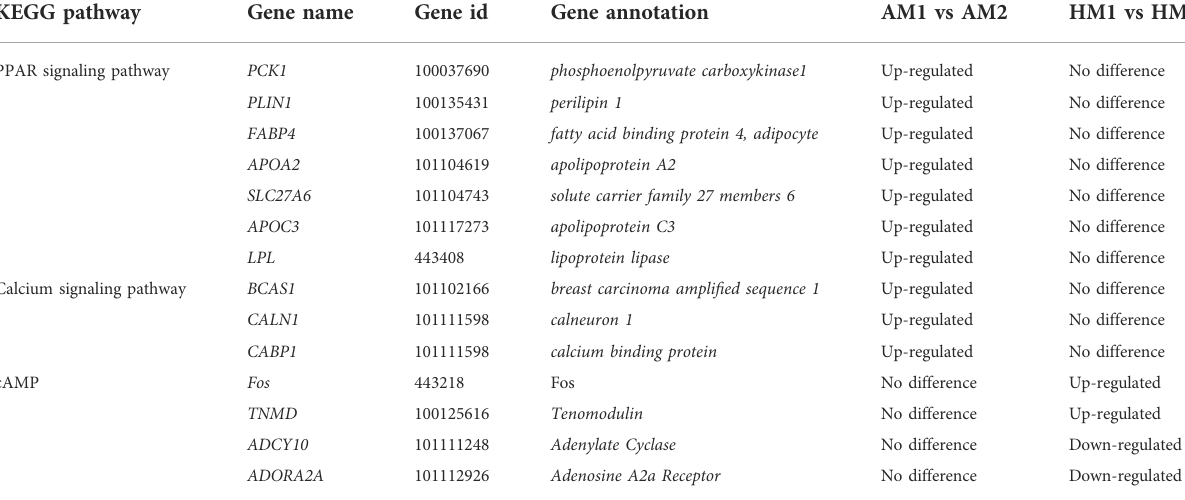
TABLE 3 The annotated DEGs related to energy homeostasis in response to cold exposure in lambs. KEGG pathway